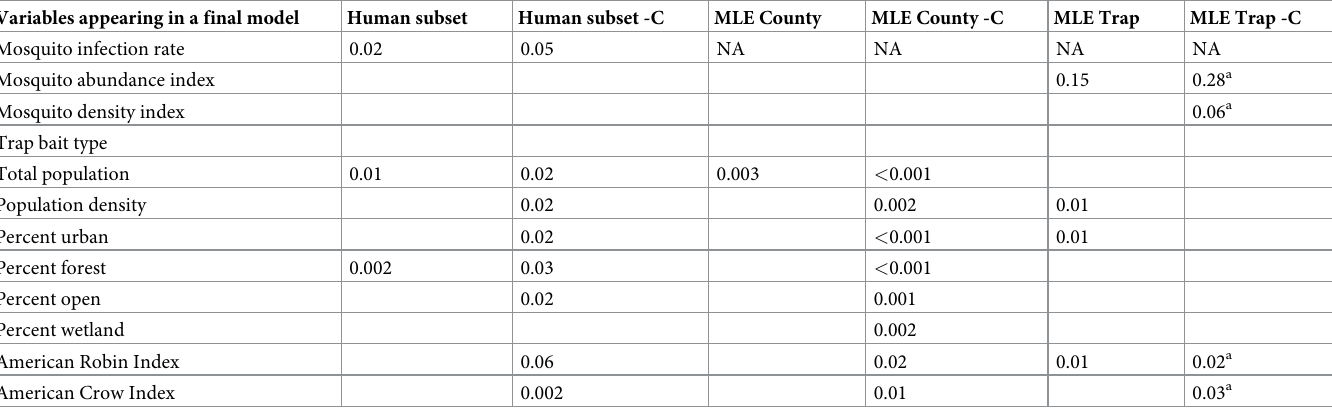
Table 5. Non-climatic variables identified as important by the random forest model when the model with all covariates was run, and when a model without climate covariates was run (-C). Model results are presented for human cases in those counties where mosquito surveillance data were collected, and for mosquito infection rates (MLE) at both the county and trap scales. Values in the table indicate the amount of unique variation explained by the variable using variance